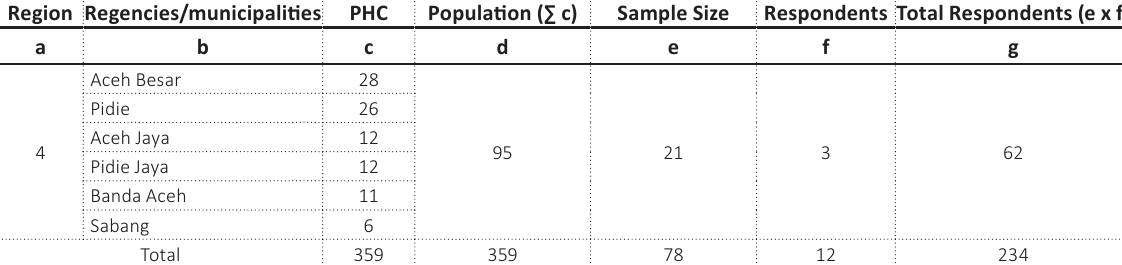
Table 1 (cont.). Sampling technique